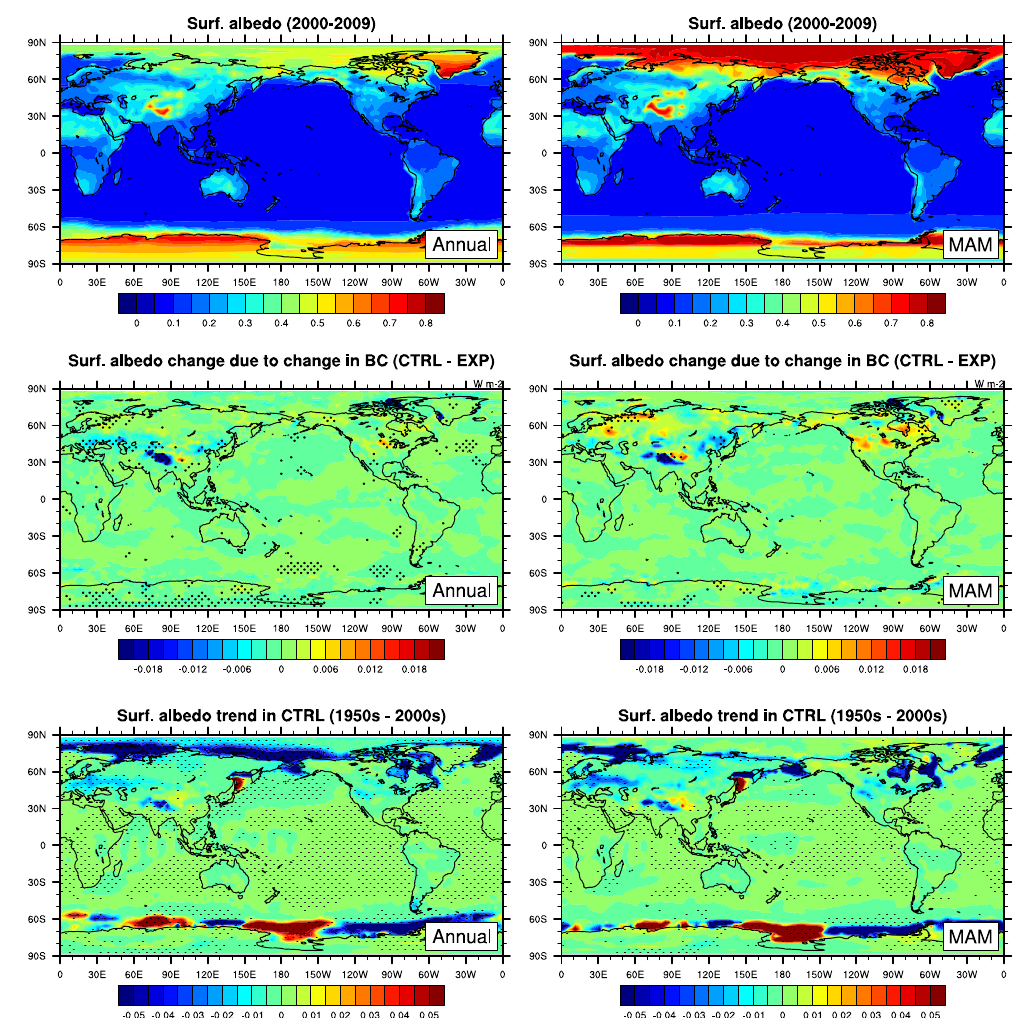
Figure 7. Annual mean (top left) and spring mean (top right) surface albedo during 2000–2009, annual mean (middle left) and spring mean (middle right) surface albedo changes due to BC in snow from the 1950s to 2000s, and annual mean (bottom left) and spring mean (bottom right) surface albedo changes due to all forcing from the 1950s to 2000s. Hatching indicates regions where the results are statistically significant ( p = 0 .